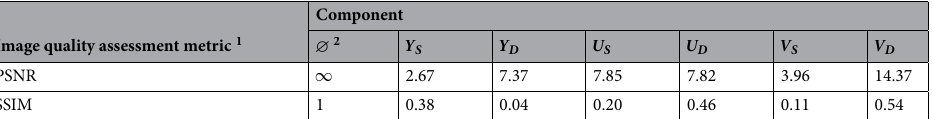
1 The difference evaluation between 2 It means no loss of components.